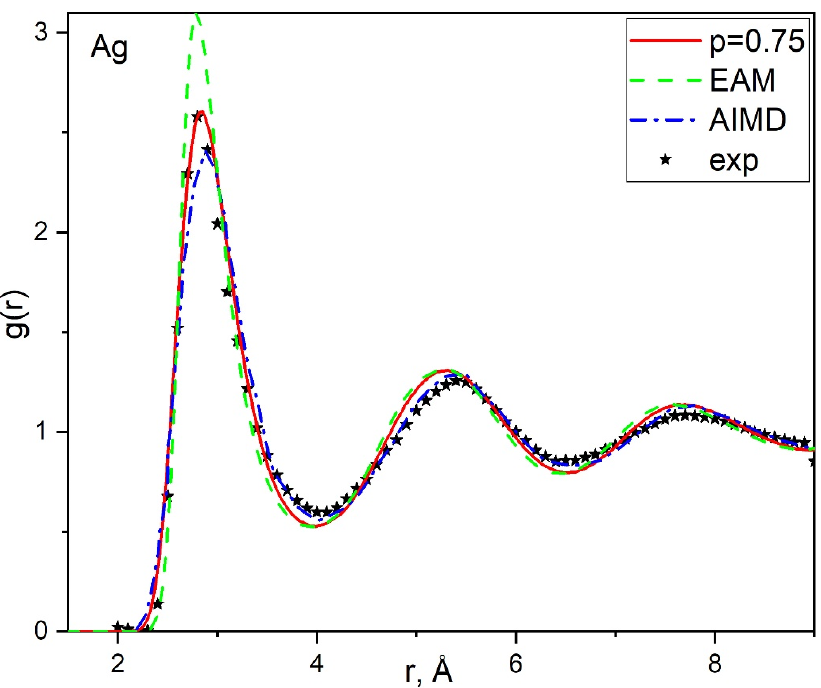
75.0 = p in comparison with